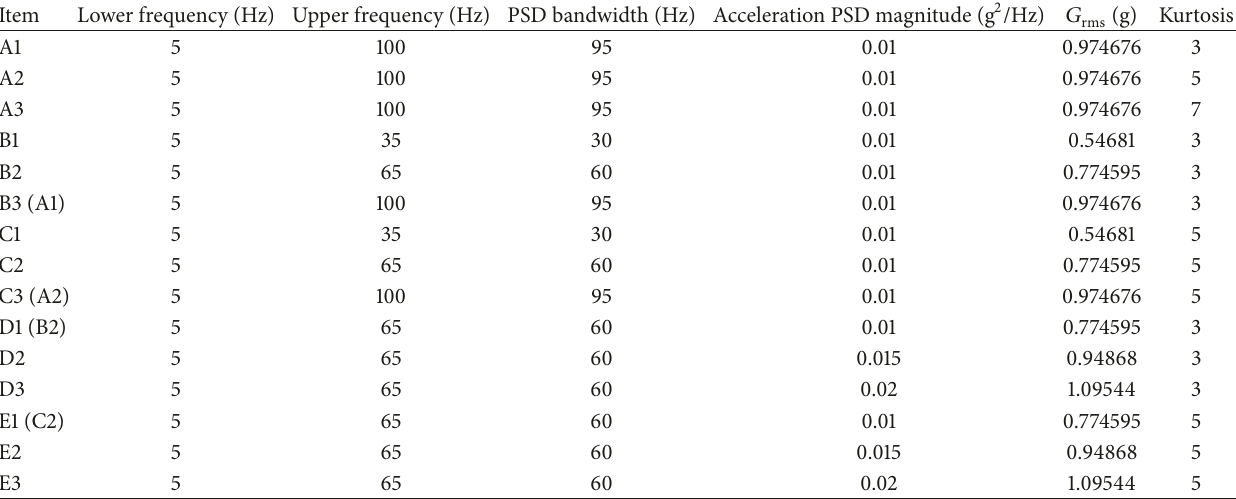
Table 4: The test conditions of Test